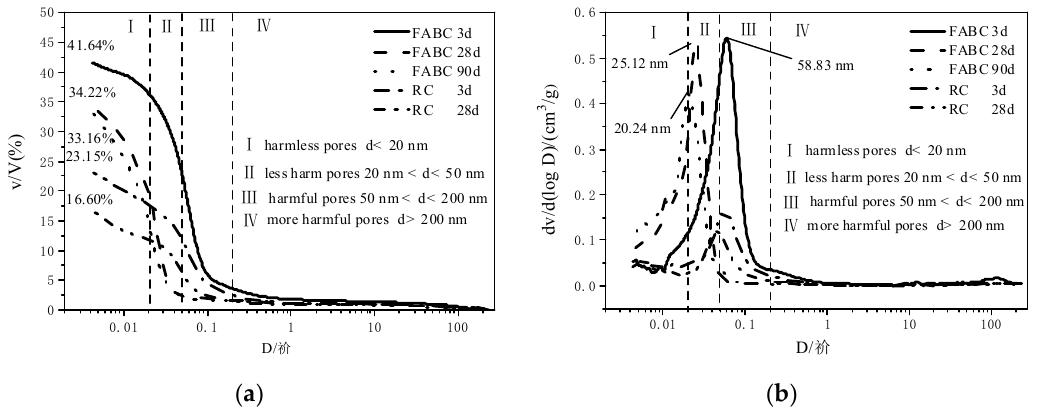
Figure 8. Cumulative porosity ( a ) and pore size distribution ( b ) of pastes hydrated for di ff erent